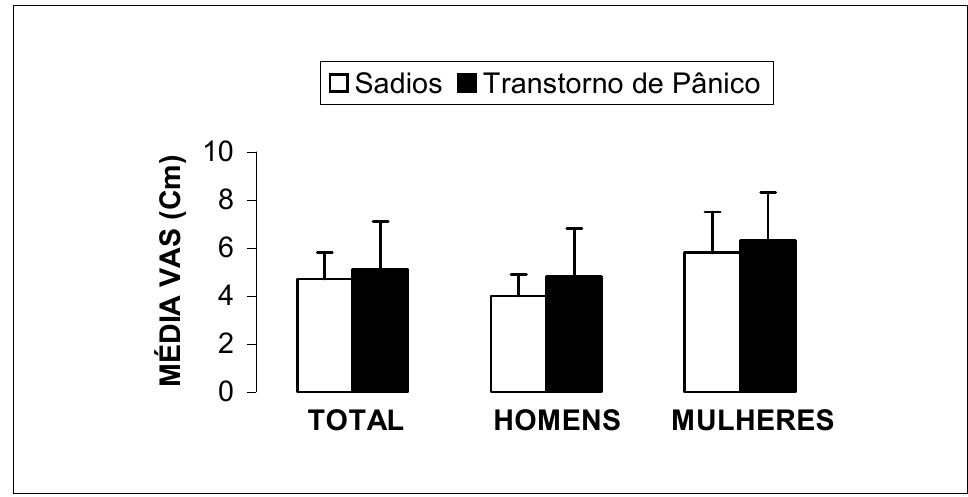
Figura 2 . Valores médios em centímetros na escala visual analógica para os participantes sadios e com transtorno de pânico. Linhas verticais representam o erro padrão da média